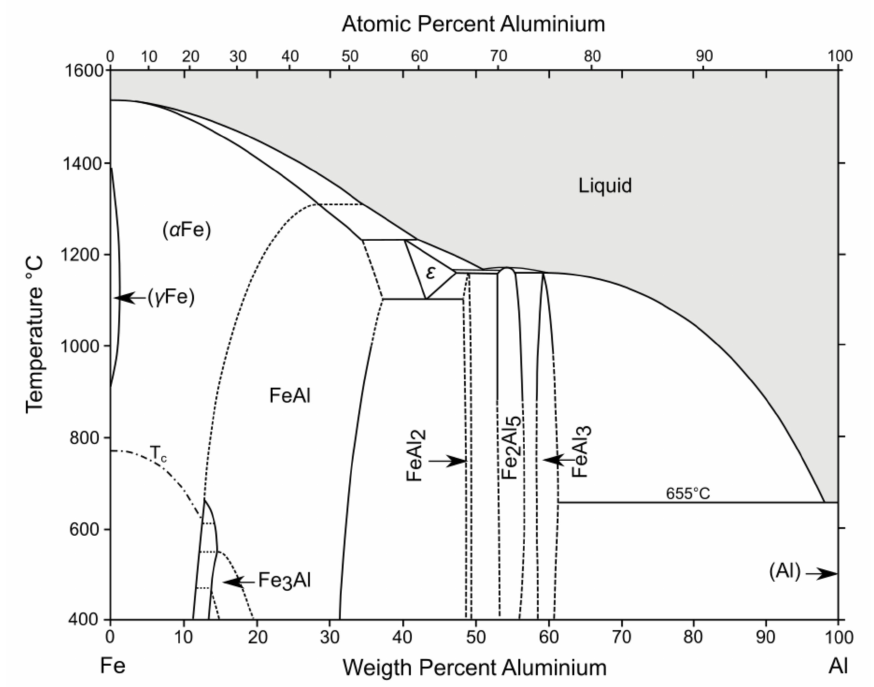
Figure 9. Binary Al–Fe phase diagram. Redrawn from [88] with